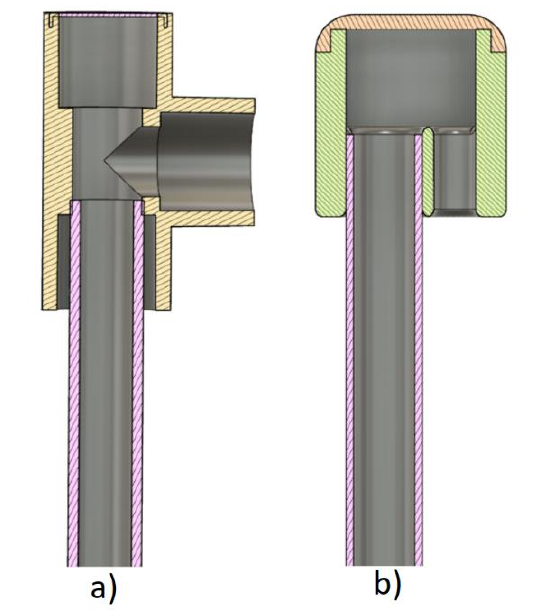
Figure 2. Cross-sections of proposed probes: ( a ) PPR and ( b ) HDPE.